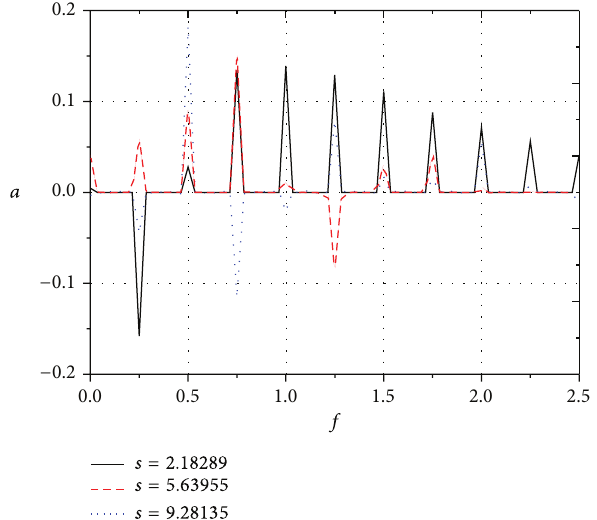
Figure 12: Growth of different frequency disturbances in boundary layer along streamwise under freestream continuous fast acoustic